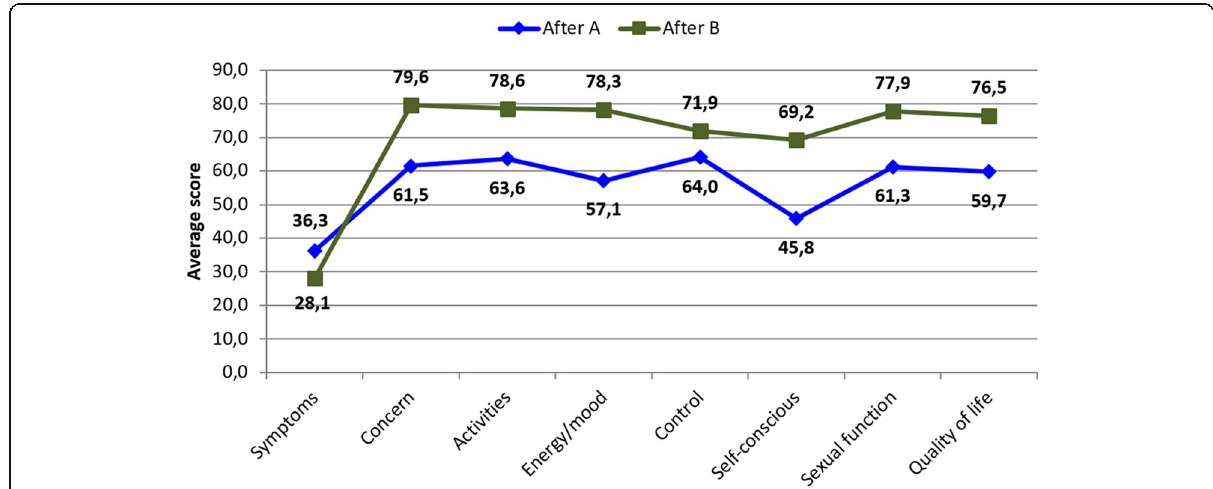
Fig. 6 Average score obtained in the UFS-QOL questionnaire, after UFE, referring to patients in group A (blue) and group B